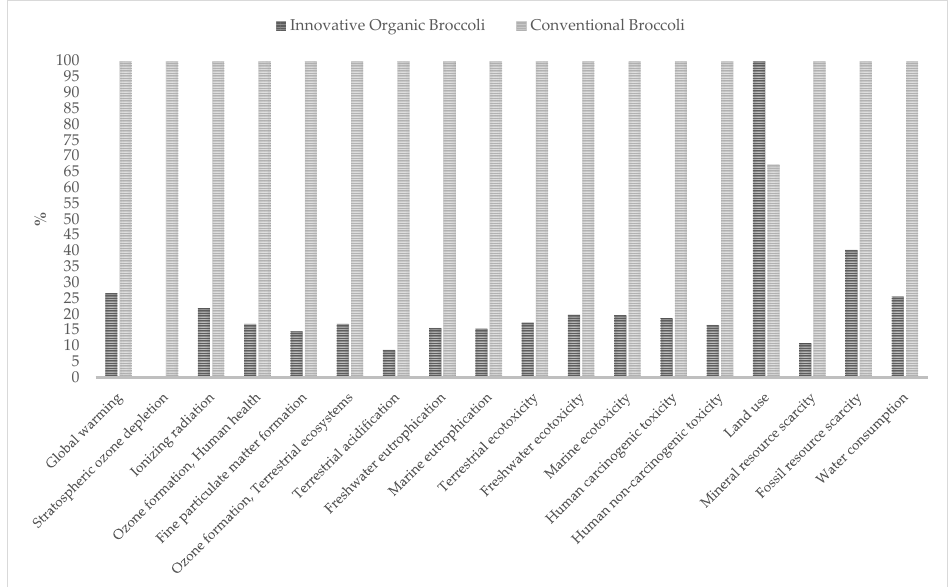
Figure 3. Impact comparison of innovative organic and conventional broccoli per kg of product (% of average value for each category). (Our elaboration on SimaPro 9.1 software).